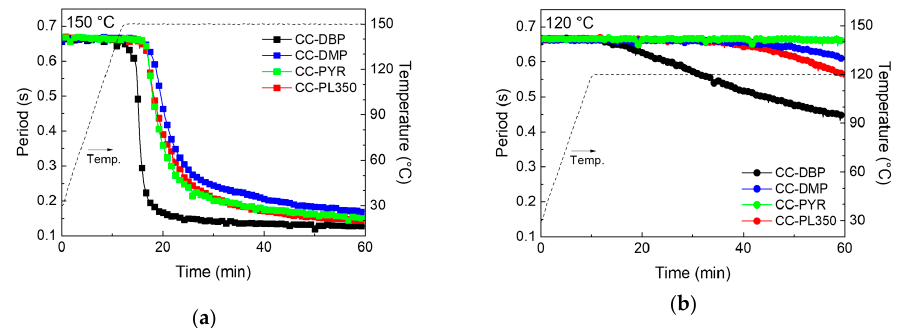
Figure 4. Rigid-body pendulum tester (RPT) results of clearcoats with various pyrazole-based BIs at curing temperatures of ( a ) 150 ◦ C and ( b ) 120 ◦ curing temperatures of ( a ) 150 °C and ( b ) 120 °C.